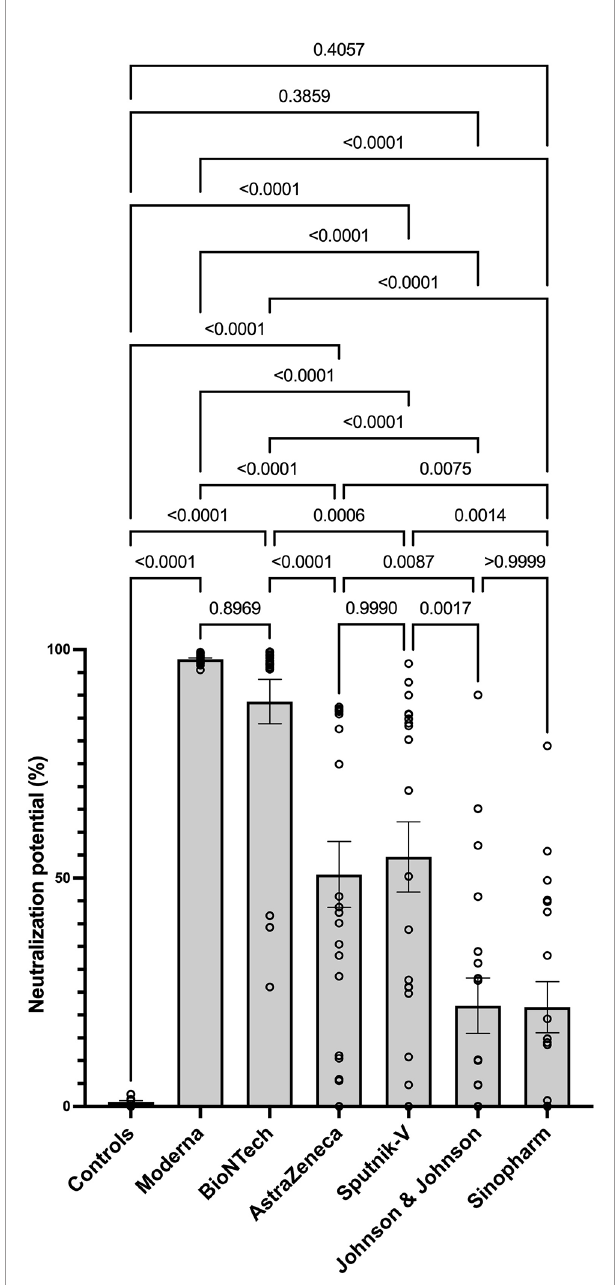
FIGURE 3 | Higher neutralizing potential of mRNA vaccines in mRNA- vaccinated individuals. The graph represents the relative neutralizing antibody expression observed using sera from each vaccination group. Each symbol represents individual donors. Indicated p values were calculated using Kruskal-Wallis ‘ test followed by Dunn ’ s comparison post hoc to compare all groups. Bars represent the mean ± SEM percentage of relative neutralizing antibody expression in each group. Signi fi cance is accepted if p